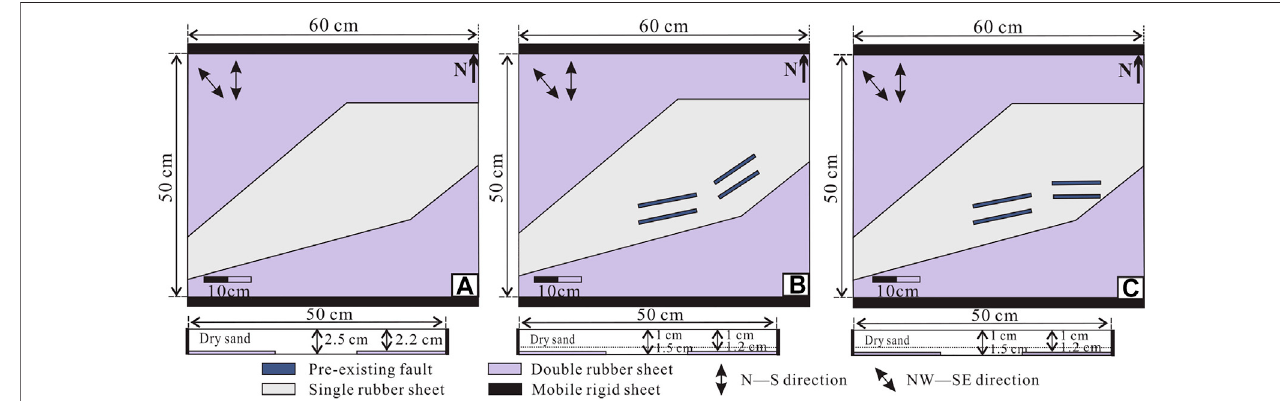
FIGURE 11 | Modeling of basin asymmetry. (A) Series I: With no pre-existing faults under two different stress directions (N-S direction and NW-SE direction). (B) Series II: With NE-SW-striking pre-existing faults under two different stress directions (N-S direction and NW-SE direction). (C) Series III: With E-W-striking pre-existing faults under two different stress directions (N-S direction and NW-SE direction).